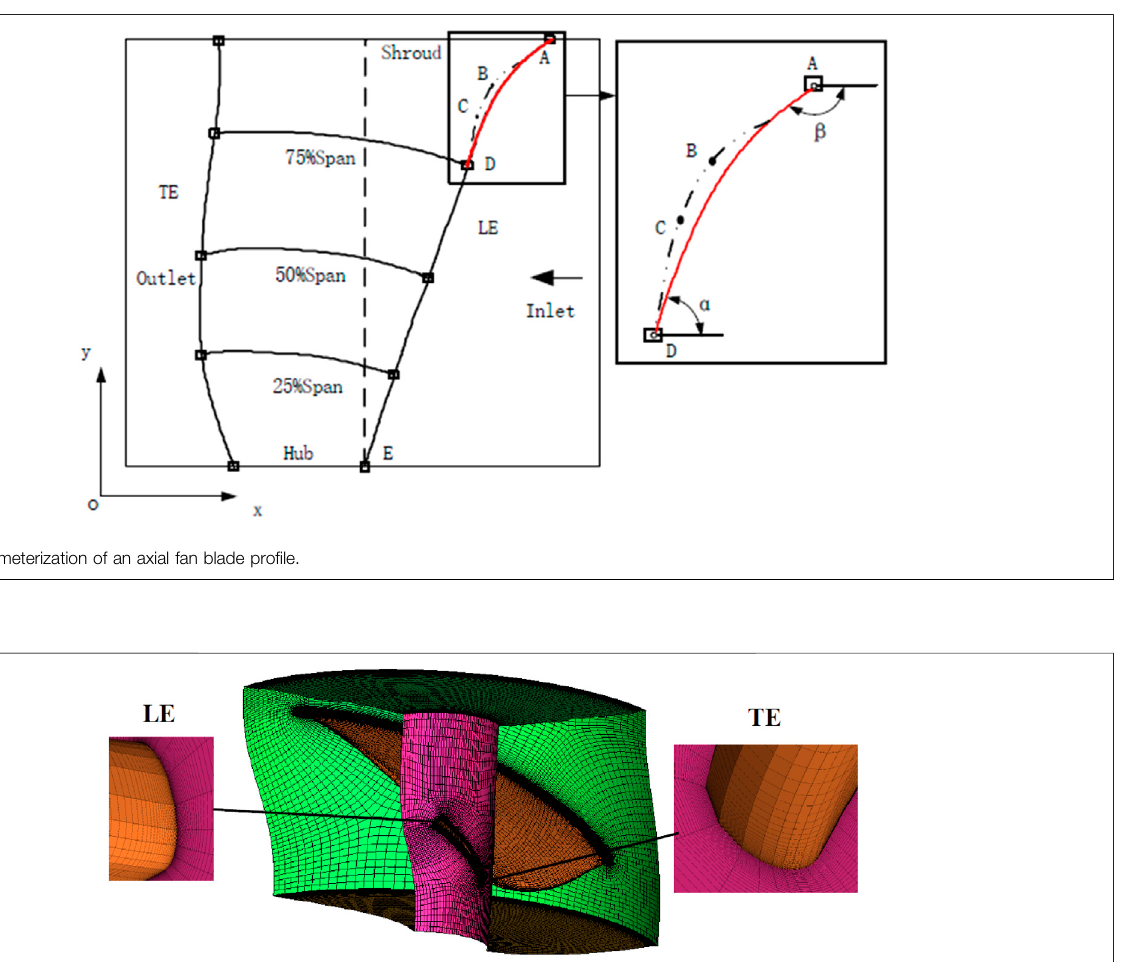
FIGURE 3 | Calculation